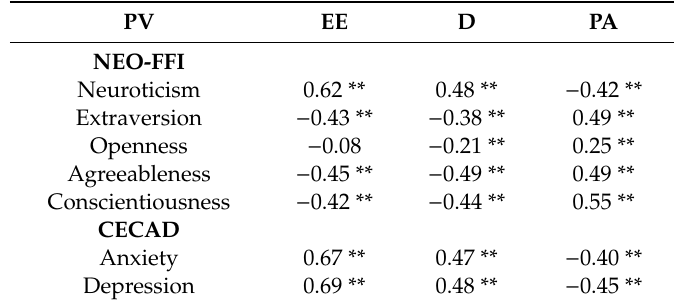
Table 4. Correlation coe ffi cients between psychological variables and Burnout.